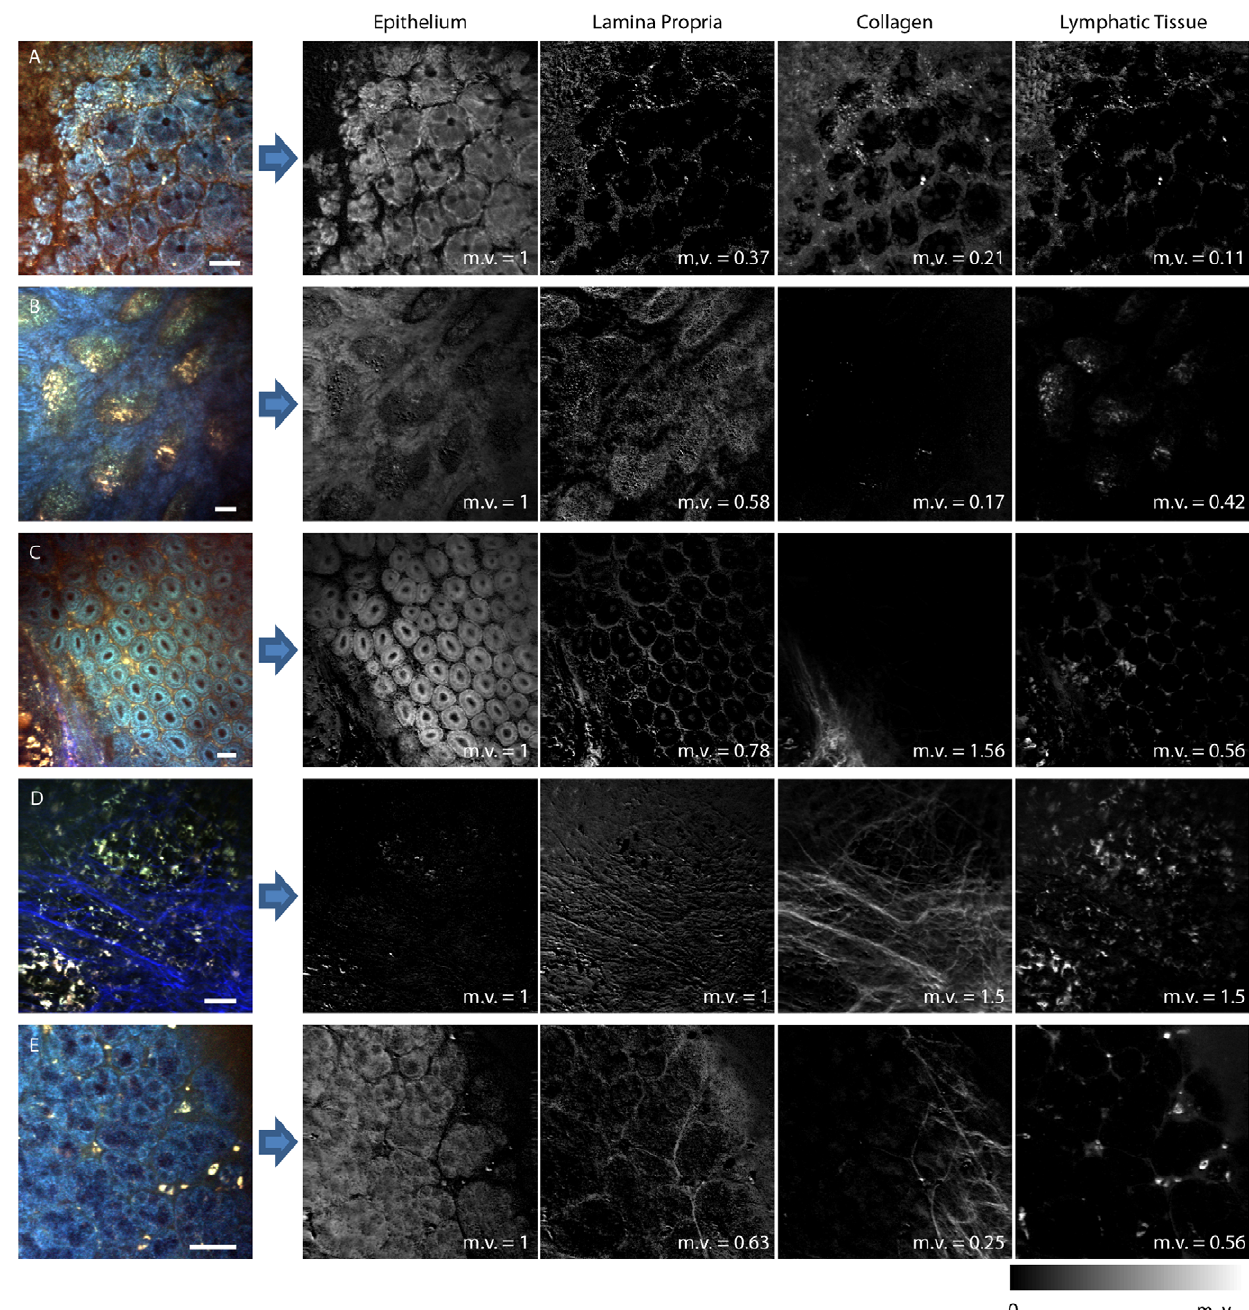
Figure 4. Hyperspectral data unmixing of images of gastric tissues using averaged basis spectra. RGB images are at 740 nm excitation, except for D is at 890 nm. Grayscale images are scaled from 0 to the maximum value (m.v.) reported in each image. (A) Image of glandular later of normal colon shows crypts and the surface epithelium. (B) Image of the villi in the small intestine. Epithelial tissue, lamina propria, and lymphatic tissue can be seen, although very little collagen is detected. (C) Image of the glandular level of the small intestine, with the edge of a Peyer’s patch in the lower left hand corner. This image was acquired in situ, through the muscularis externa and serosa. All four tissue types are represented in this data set. (D) Image of the center of a Peyer’s patch in the small intestine. A strong network of collagen and dense and evenly spaced lymphatic cells are visible. (E) A cancerous lesion in the small intestine of an APC min + /mouse. The epithelial structure is very different to that seen in normal tissues, and the presence of collagen is a feature of neoplasia. Scale bars are all 50 m